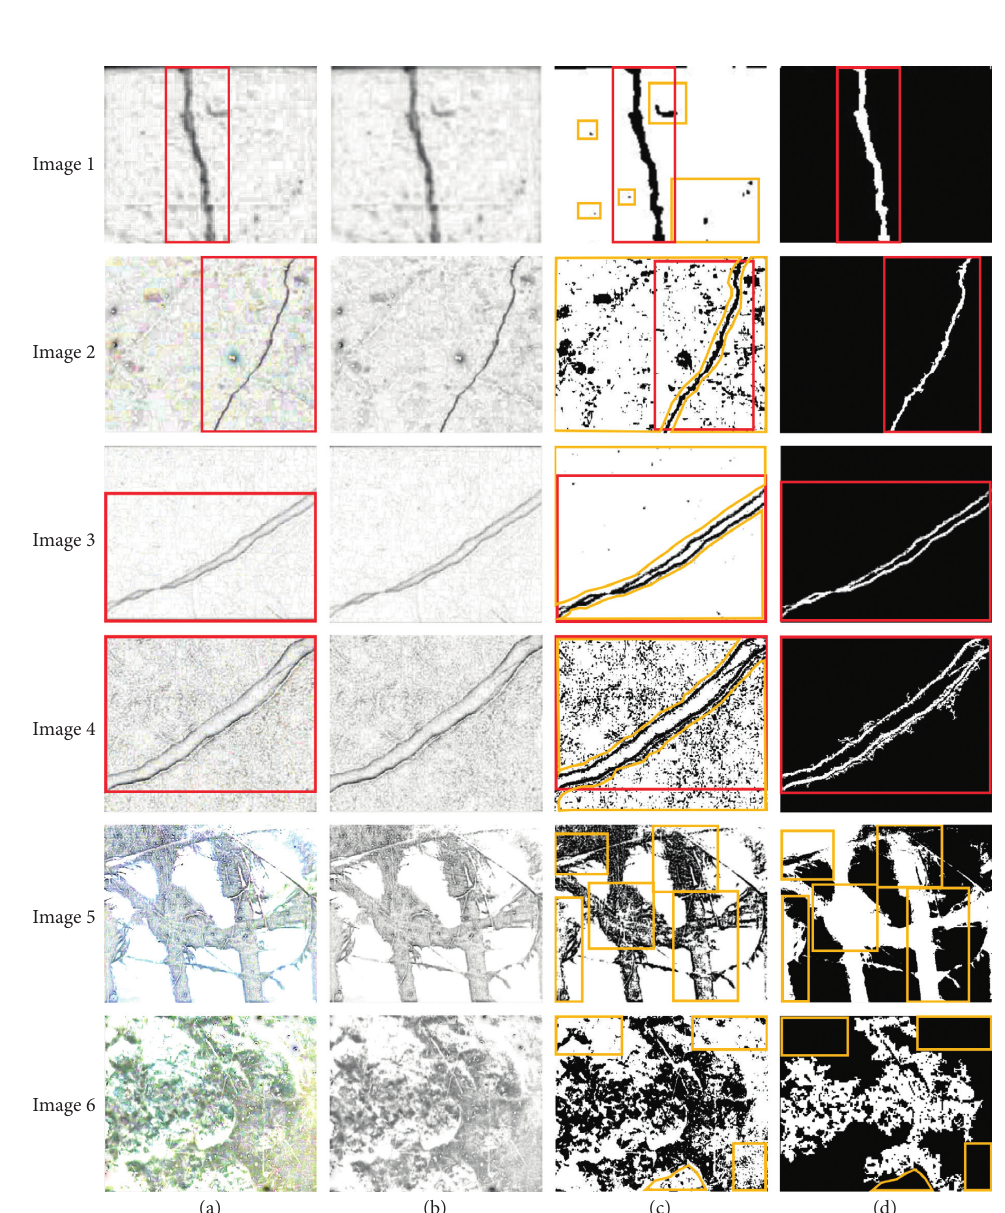
Figure 7: Screening of disease edges in images. (a) Image processed by the DR algorithm. (b) Image graying. (c) Binary image. (d) Image inversion and edge